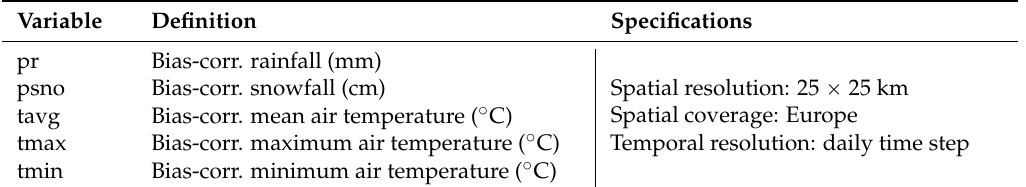
Table 3. List of RCM variables considered in this study and data specifications. Bias correction was conducted by Dosio et al.